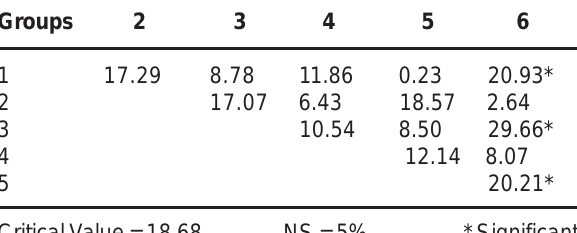
Critical Value = 18.68